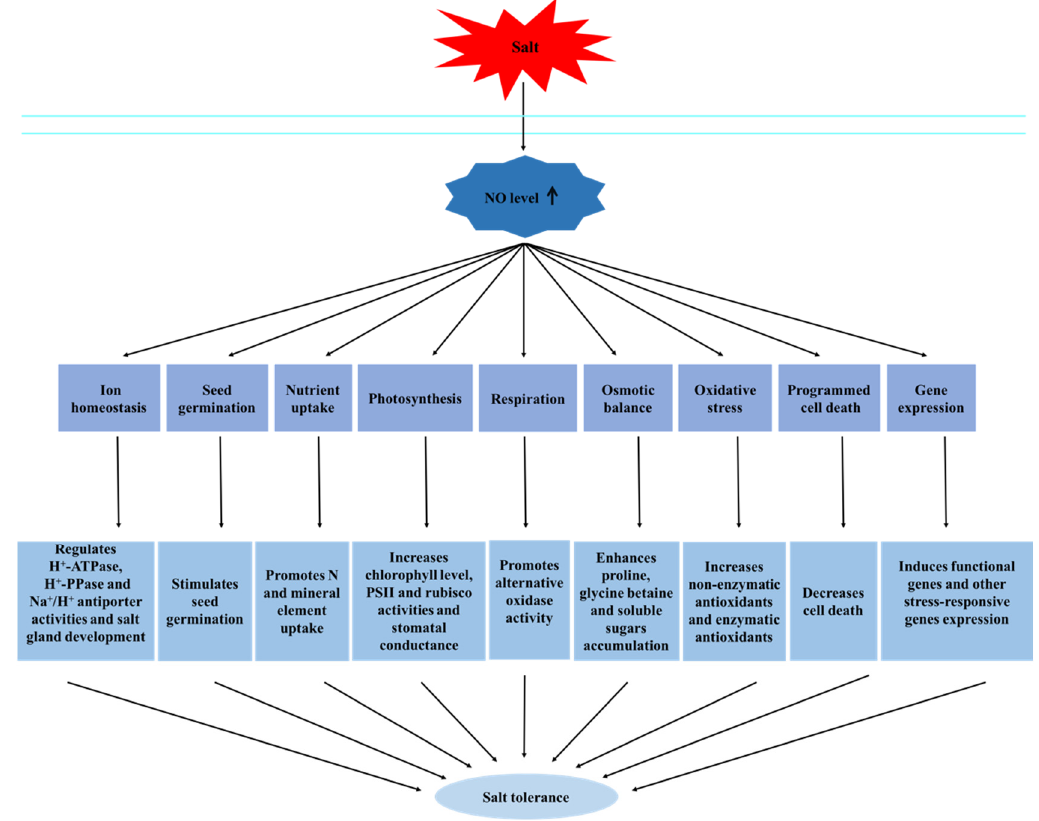
Figure 1. NO mediates salt tolerance through different strategies.